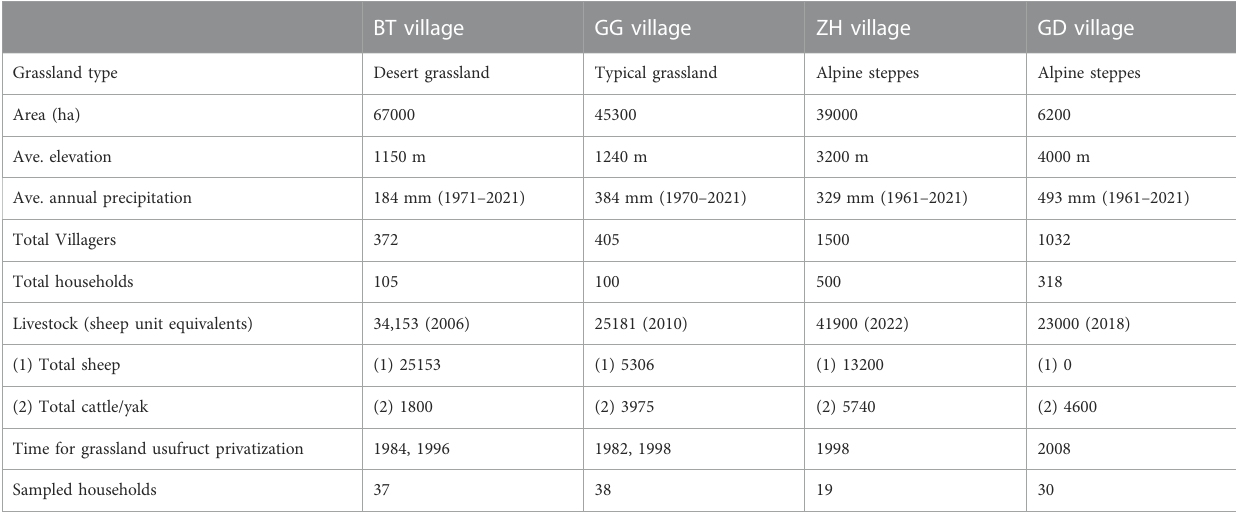
TABLE 1 Natural conditions, population and grassland conditions of four